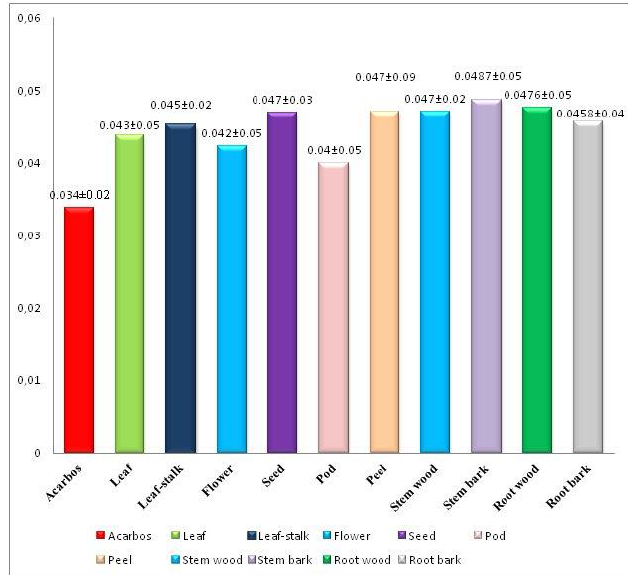
Figure 1: IC 50 (mg/mL) values from α-amylase inhibition of Calophyllum inophyllum Linn. Data were analyzed by non-linear regression analysis on MS Excel from the mean inhibitory data. IC 50 - Concentration of essential oil that scavenged 50% of acarbose.